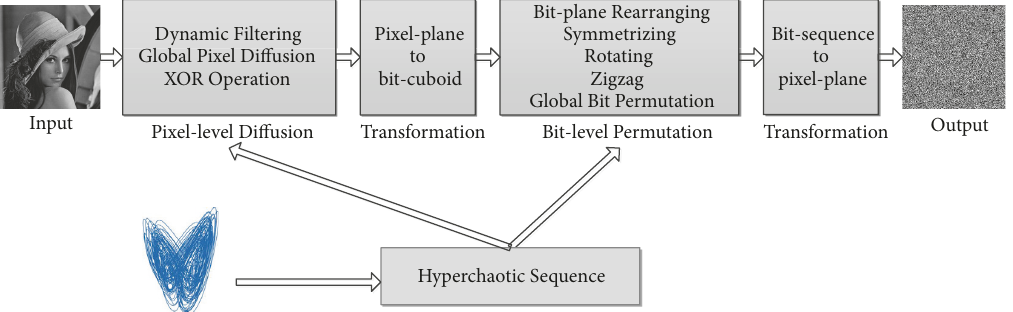
Figure 6: The framework of the